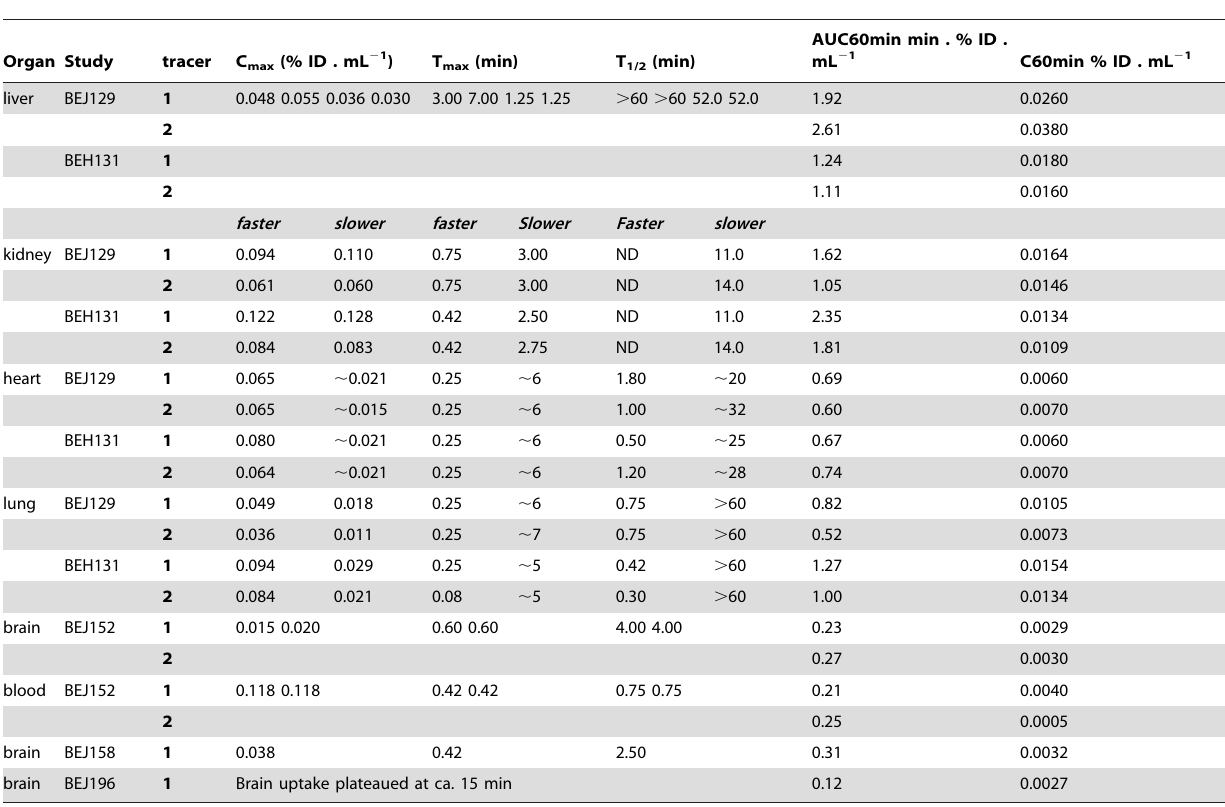
Table 2. Pharmacokinetics assessment of alcohol after iv administration to baboon.